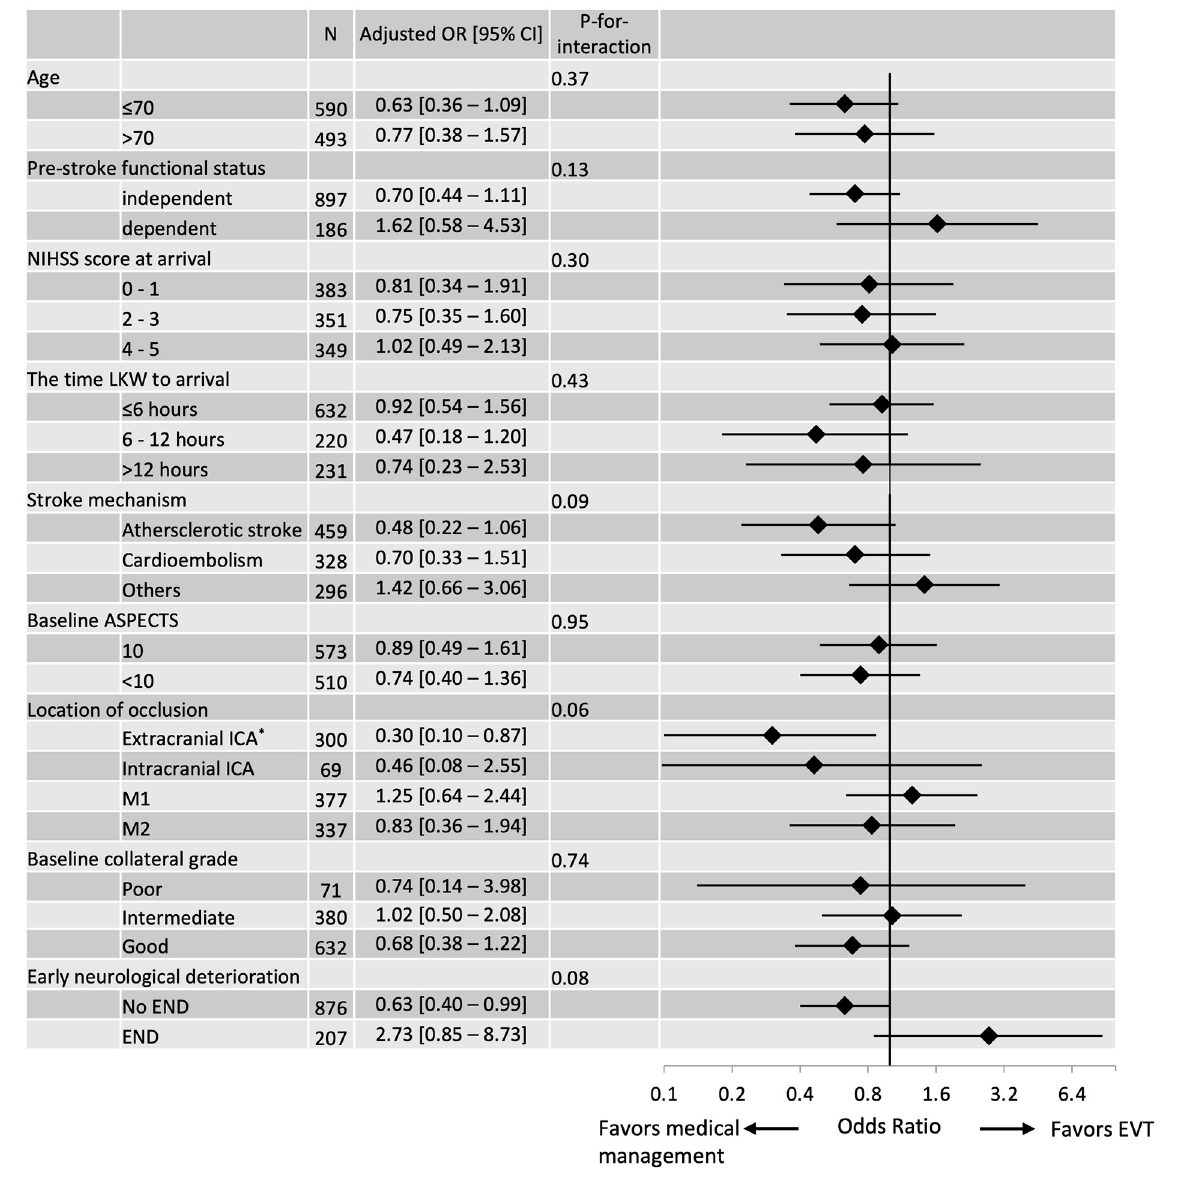
FIGURE1 Subgroup analyses of EVT effectiveness were assessed using 90-day mRS 0–1 and stratified by selected baseline characteristics. The vertical line signifies the null point (OR 1.00). Adjusted ORs and 95% CIs were calculated using multivariable logistic regression models without applying the propensity score. * Extracranial ICA includes tandem